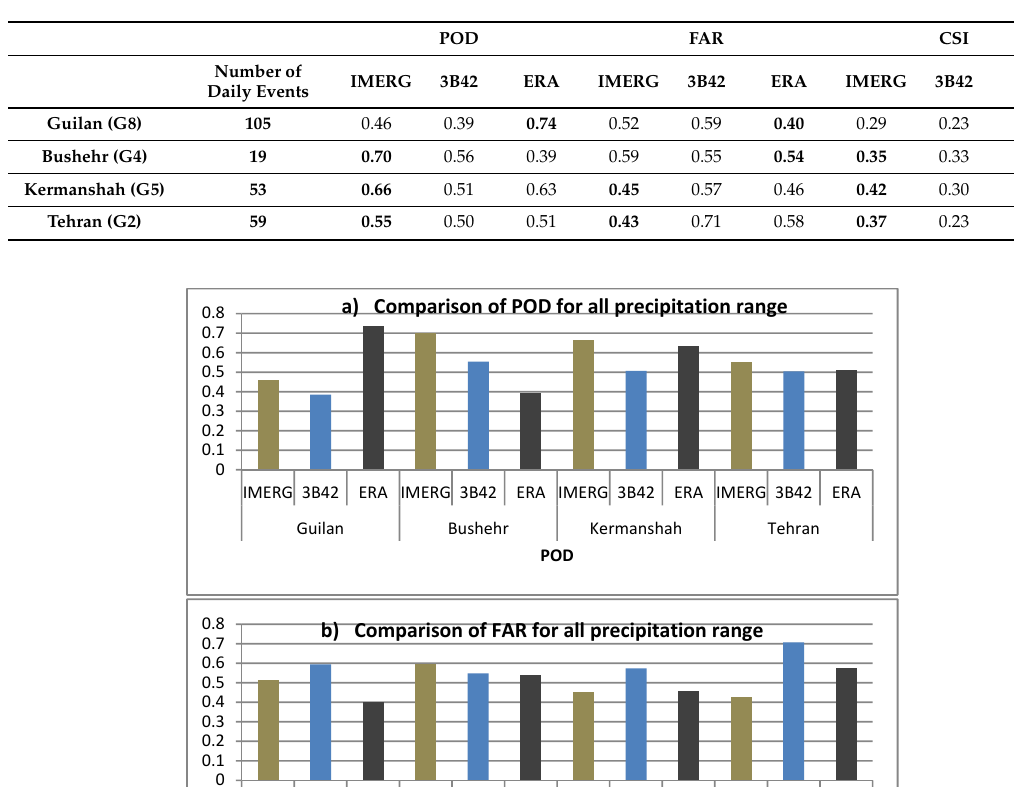
Table 16. Spatially averaged POD, FAR and CSI metrics.